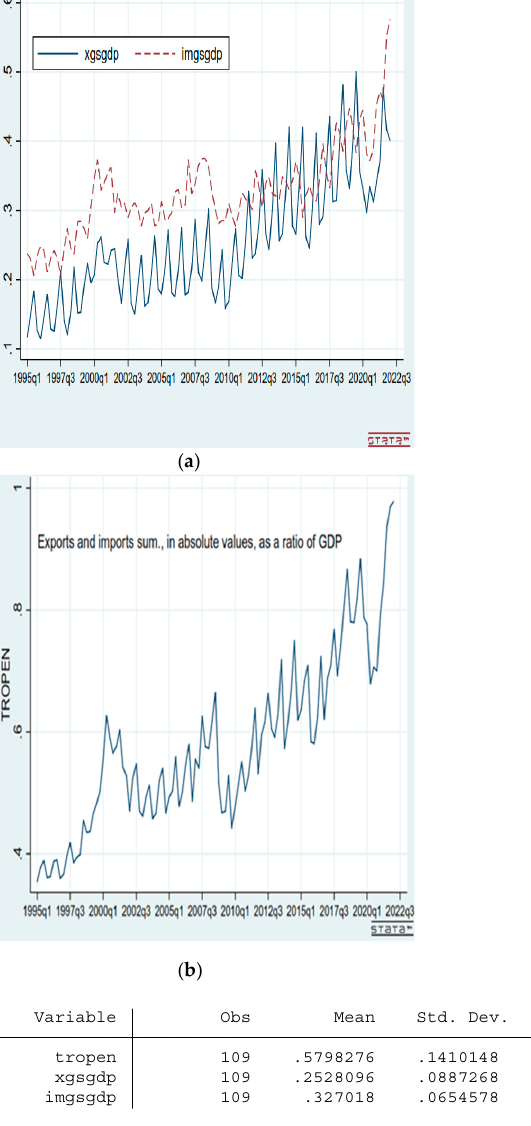
Figure A4 . ( a ) Greek Exports and Impots of Goods and Services as a ration to GDP. ( b ) Trade Openness of